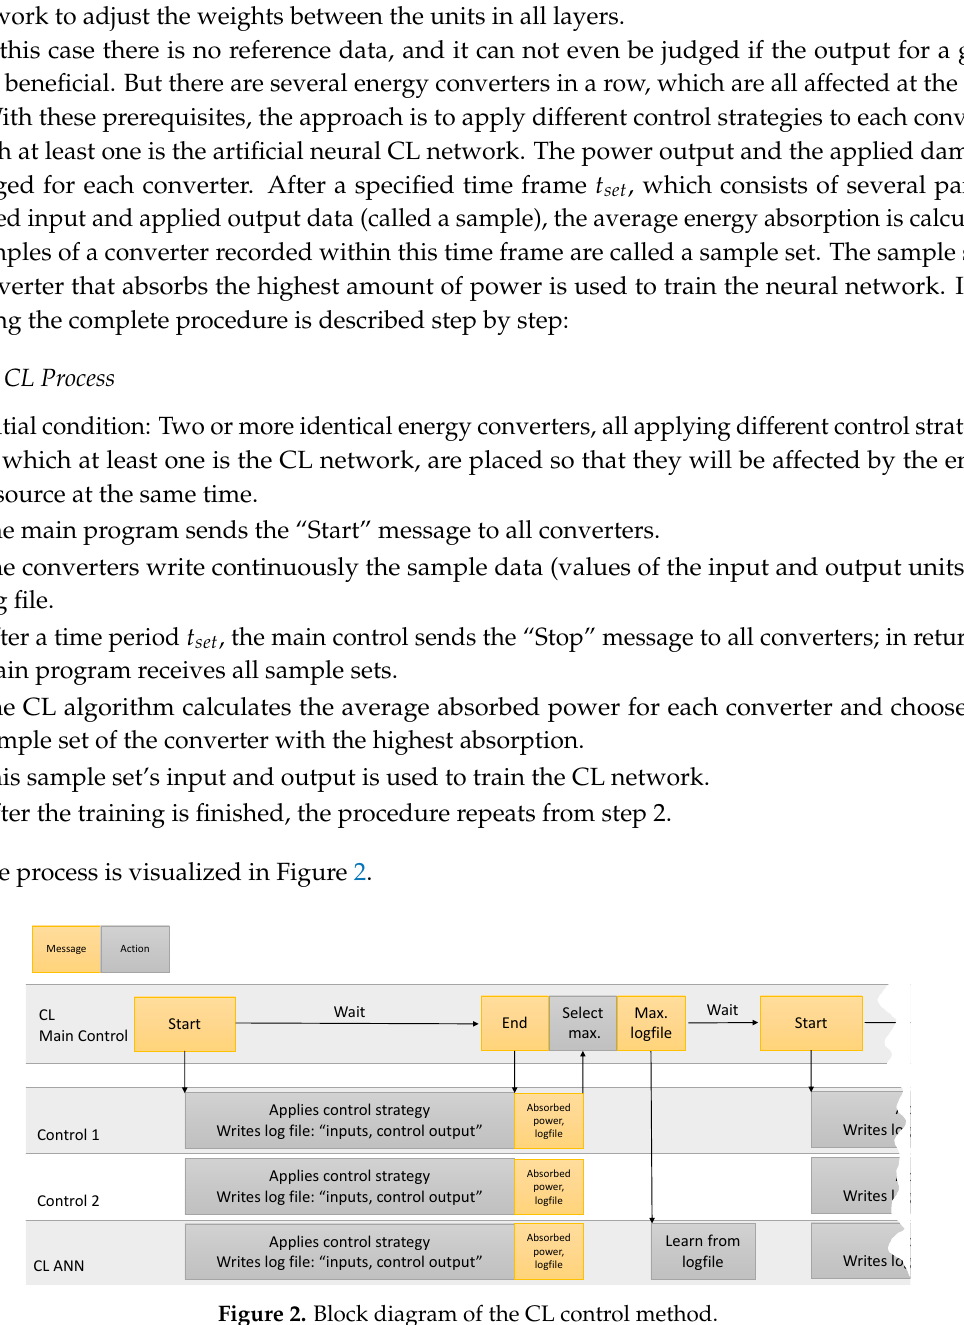
Figure 2. Block diagram of the CL control